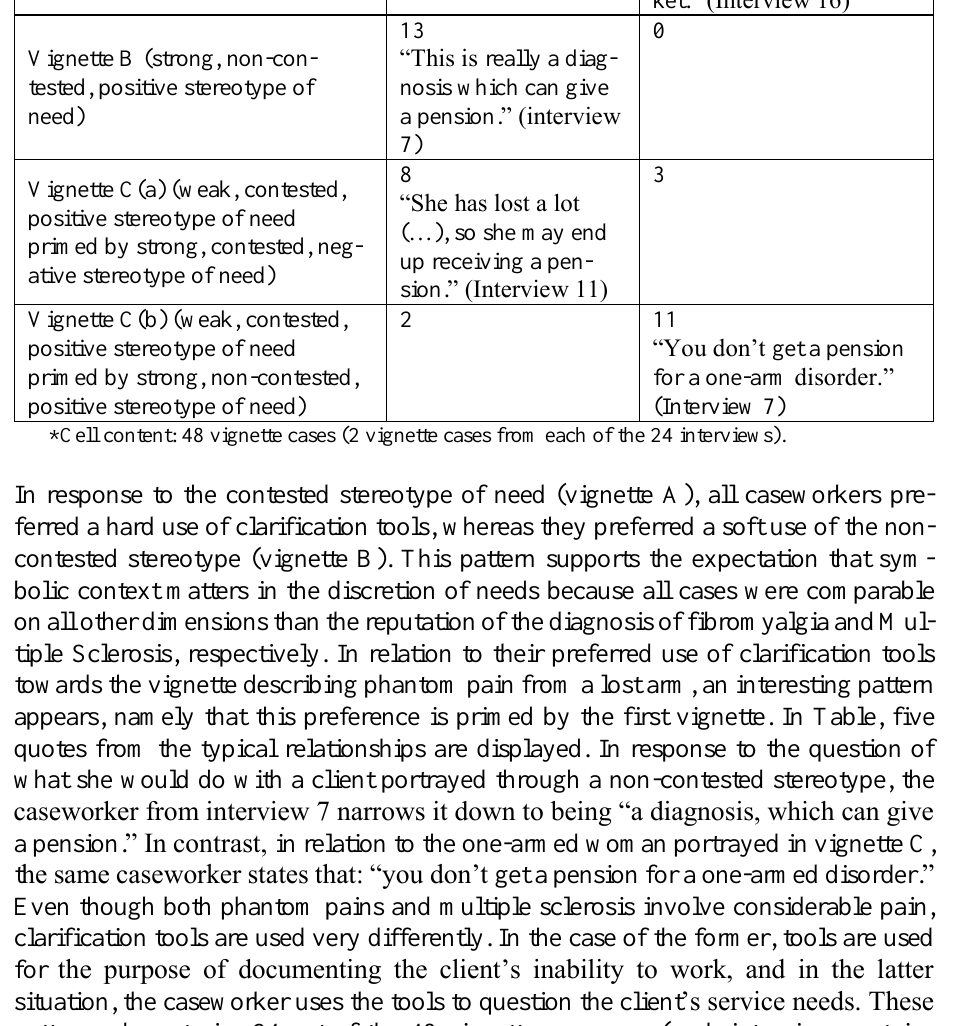
Hard use of clarification